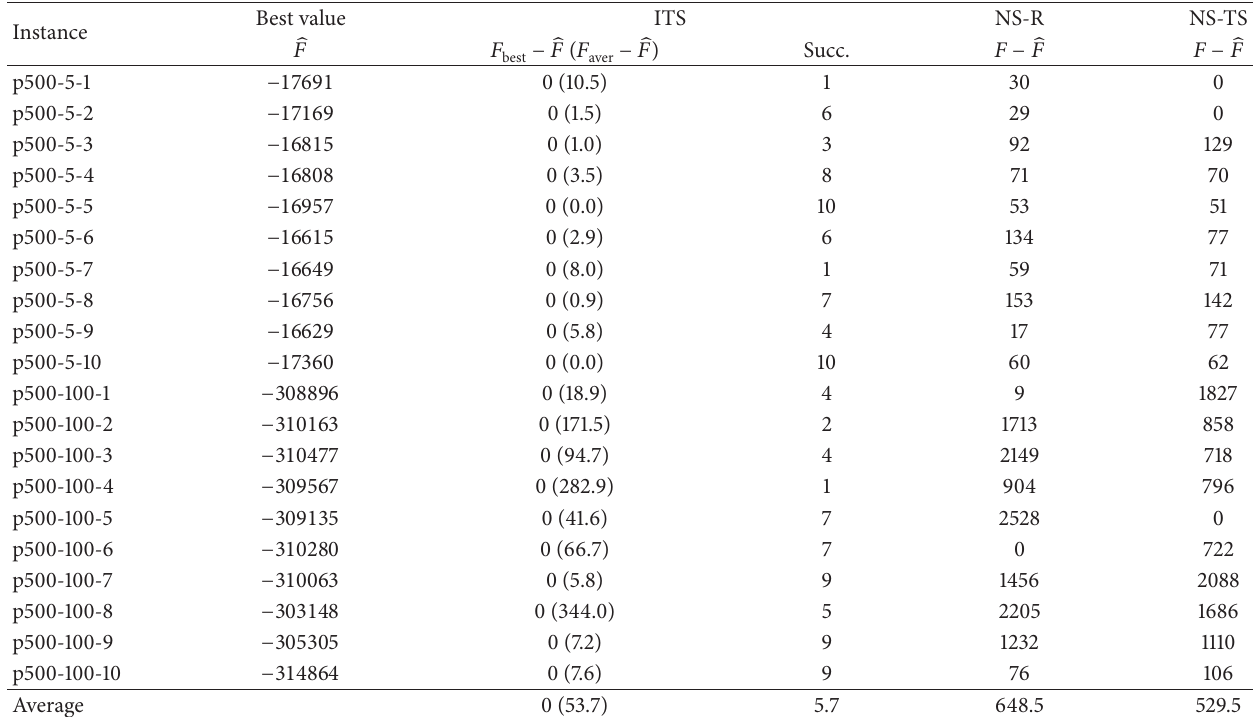
Table 2: Comparison of ITS with NS-R and NS-TS on the CPP instances of size